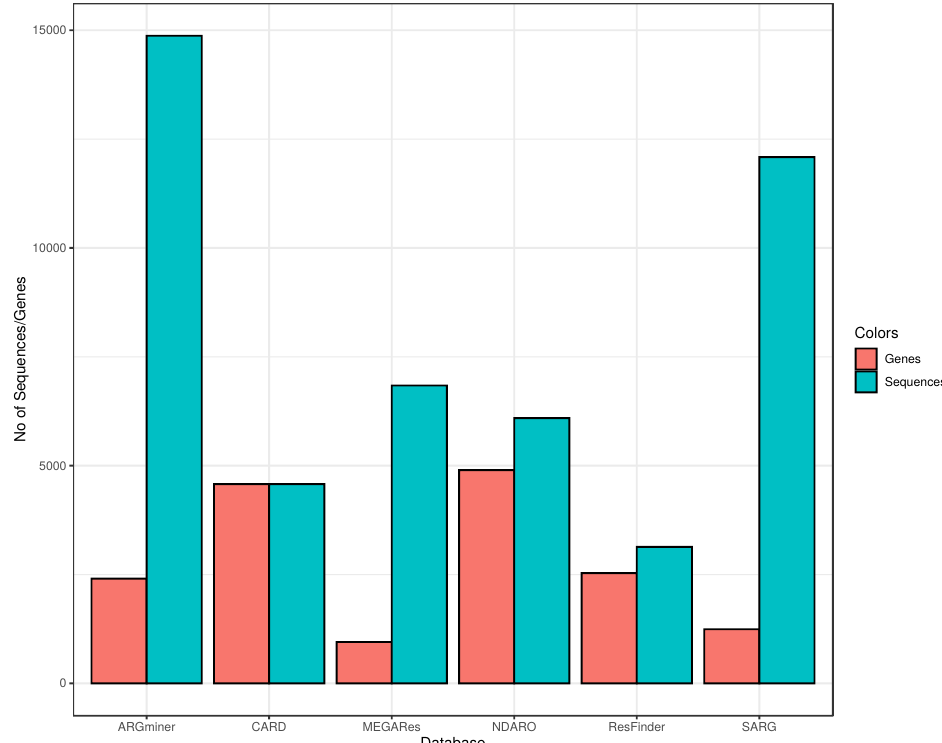
Figure 1. ARG and sequence content of the databases. Only antibiotic and biocide resistance genes were considered for the plot. For each database on the x axis, the number of unique sequences and the corresponding number of unique genes were determined. The y axis represents the number of genes and sequences. Red bars show the gene number while blue bars represent the number of sequences stored in each